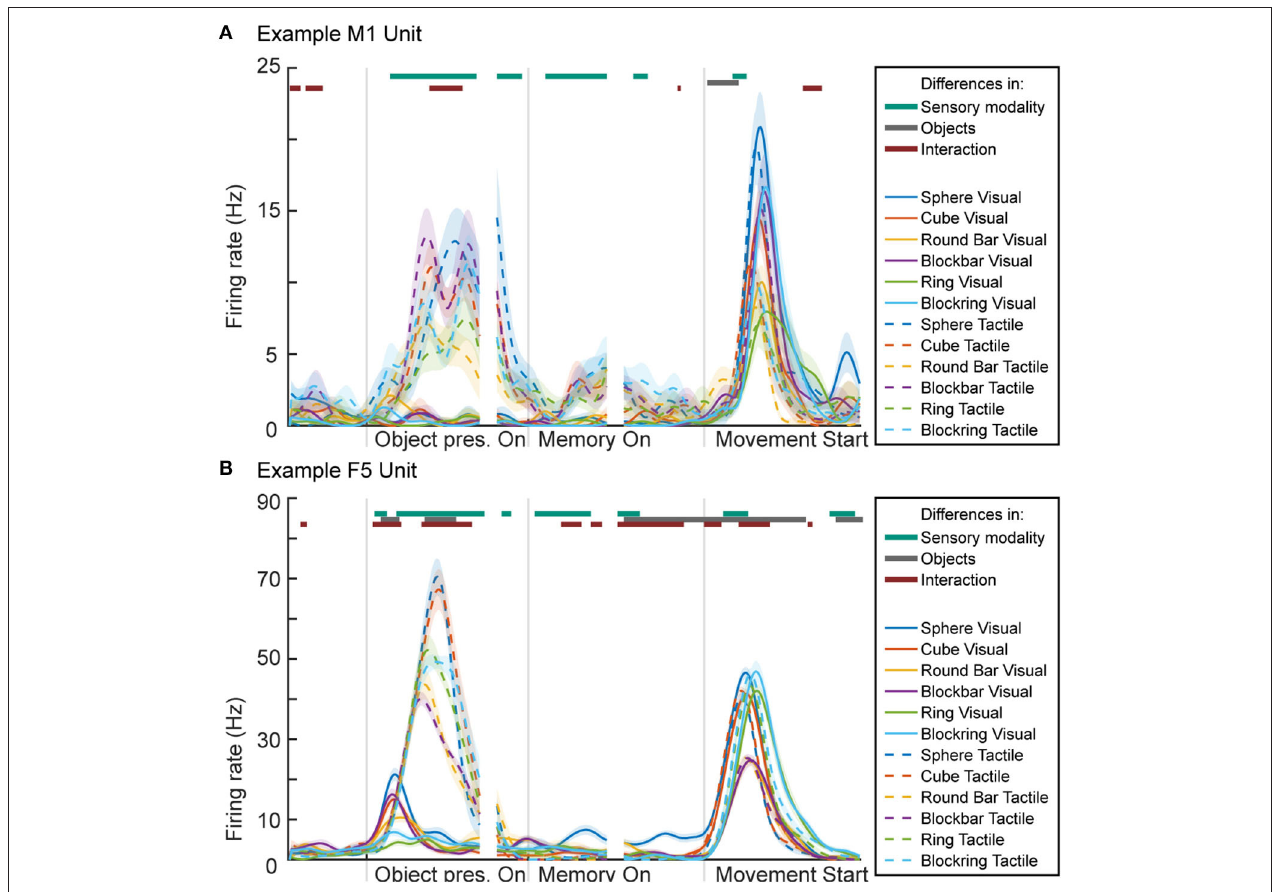
FIGURE 10 | Peri-event time histogram of two example units from primary motor cortex (M1 unit) and premotor area F5 (F5 unit). (A) Activity during the two tasks of one M1 unit, showing higher activity during periods and task conditions that contain movement. (B) Activity of one F5 unit, showing activity during movement-related epochs as well as during object illumination. Colored dashed or solid lines: mean firing rate across trials for the visual task (solid lines) and tactile task (dashed lines) and the six objects: sphere, cube, round bar, block bar, ring, and block ring (different colors). Horizontal bars on top of the panels indicate periods with significant selectivity for sensory modality (vision vs. tactile; purple), object conditions (green), and interaction (blue); 2-way ANOVA with Bonferroni correction ( p < 0.0001), see